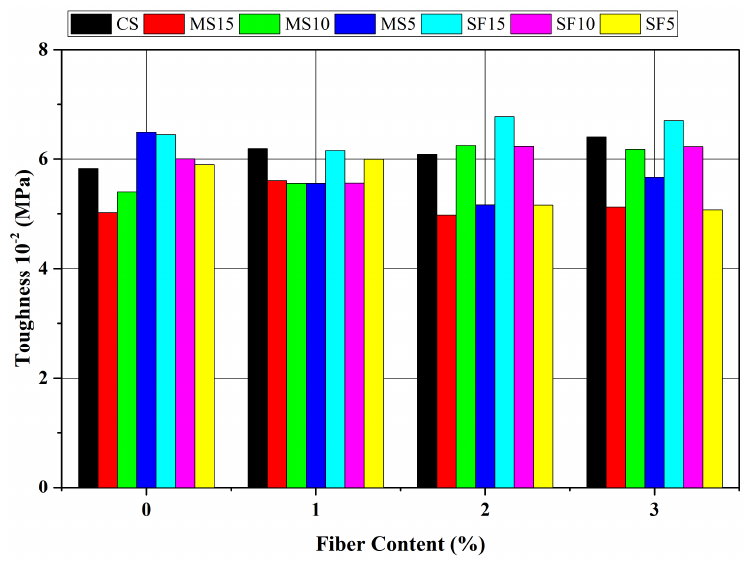
Figure 23. Toughness values of the mortar samples with various fiber contents .